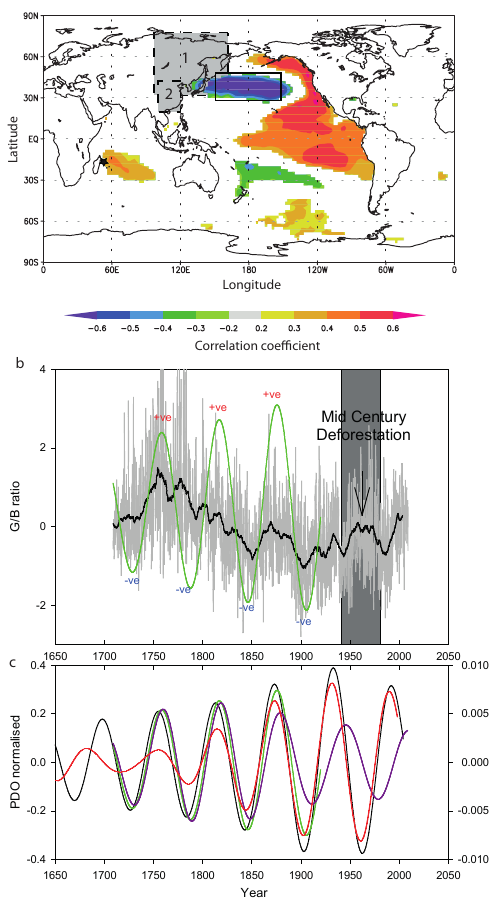
Fig. 5. Typical positive PDO phase (a) indicated by global SST anomalies. Yearly (May–April) global SST (ERSSTv.3) correlate with the PDO index (Mantua et al., 1997), with positive and neg- ative anomalies at > 95% significance level indicated by colours. The black outlined box on the map (a) shows the strong negative anomalies of the central North Pacific during a positive PDO phase. The grey shaded box 1 (a) indicates the region used to compile the NE Asian 500yr reconstructed tree ring PDO index (D’Arrigo and Wilson, 2006), and box 2 the region used to compile the eastern China 530yr reconstructed drought/flood PDO index (Shen et al., 2006). Monthly MASB G/B (grey line) and the 11yr running mean (black line) are shown (b) together with the 50–70yr band pass- filtered (0 . 017 ± 0 . 003) data up to 1920 (green). Peaks and troughs (b) represent multidecadal positive (red) and negative (blue) runoff anomalies. The same 50–70yr band pass filter (c) is also applied to the NE Asia PDO reconstruction (black), the eastern China PDO re- construction (red), MASB G/B 1708–2008 (purple) and MASB G/B 1708–1920 (green). Both PDO reconstructions are coherent with the MASB G/B 1708–1920 time series (c) , therefore positive PDO phases are associated with positive runoff anomalies. When consid- ering the total MASB G/B time series (1708–2008), the relationship with both PDO reconstructions breaks down post